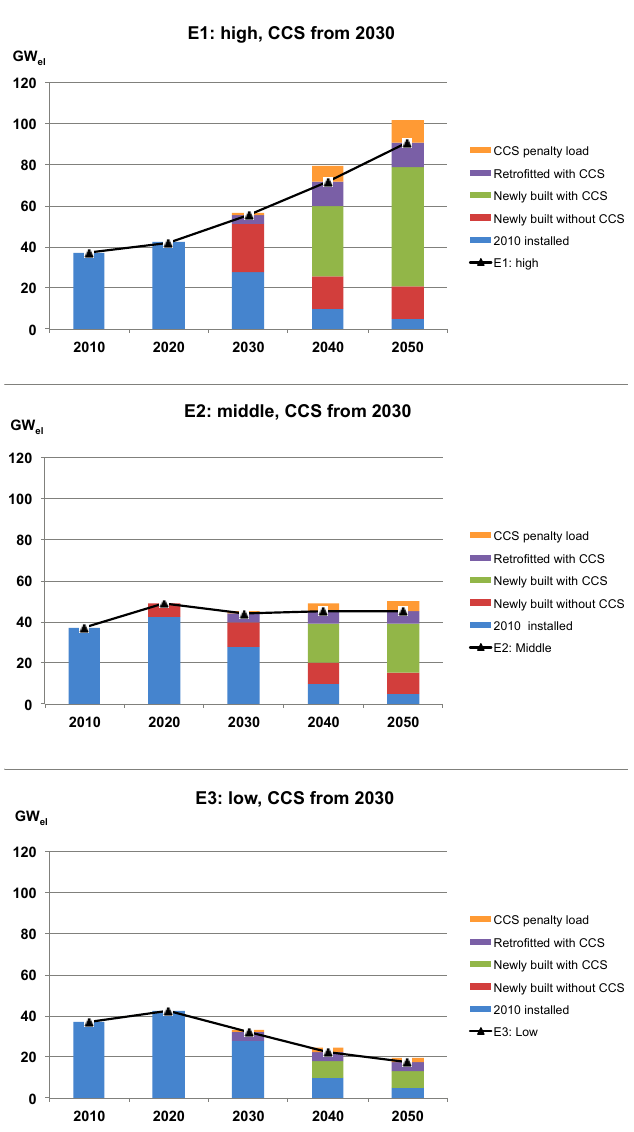
Figure 1. Conventional and CCS ‐ based coal ‐ fired power plant capacity installed in South Africa in Figure 2. Conventional and CCS-based coal-fired power plant capacity installed in South Africa in the the three pathways E1–E3 for the base case (CCS from 2030). three pathways E1–E3 for the base case (CCS from